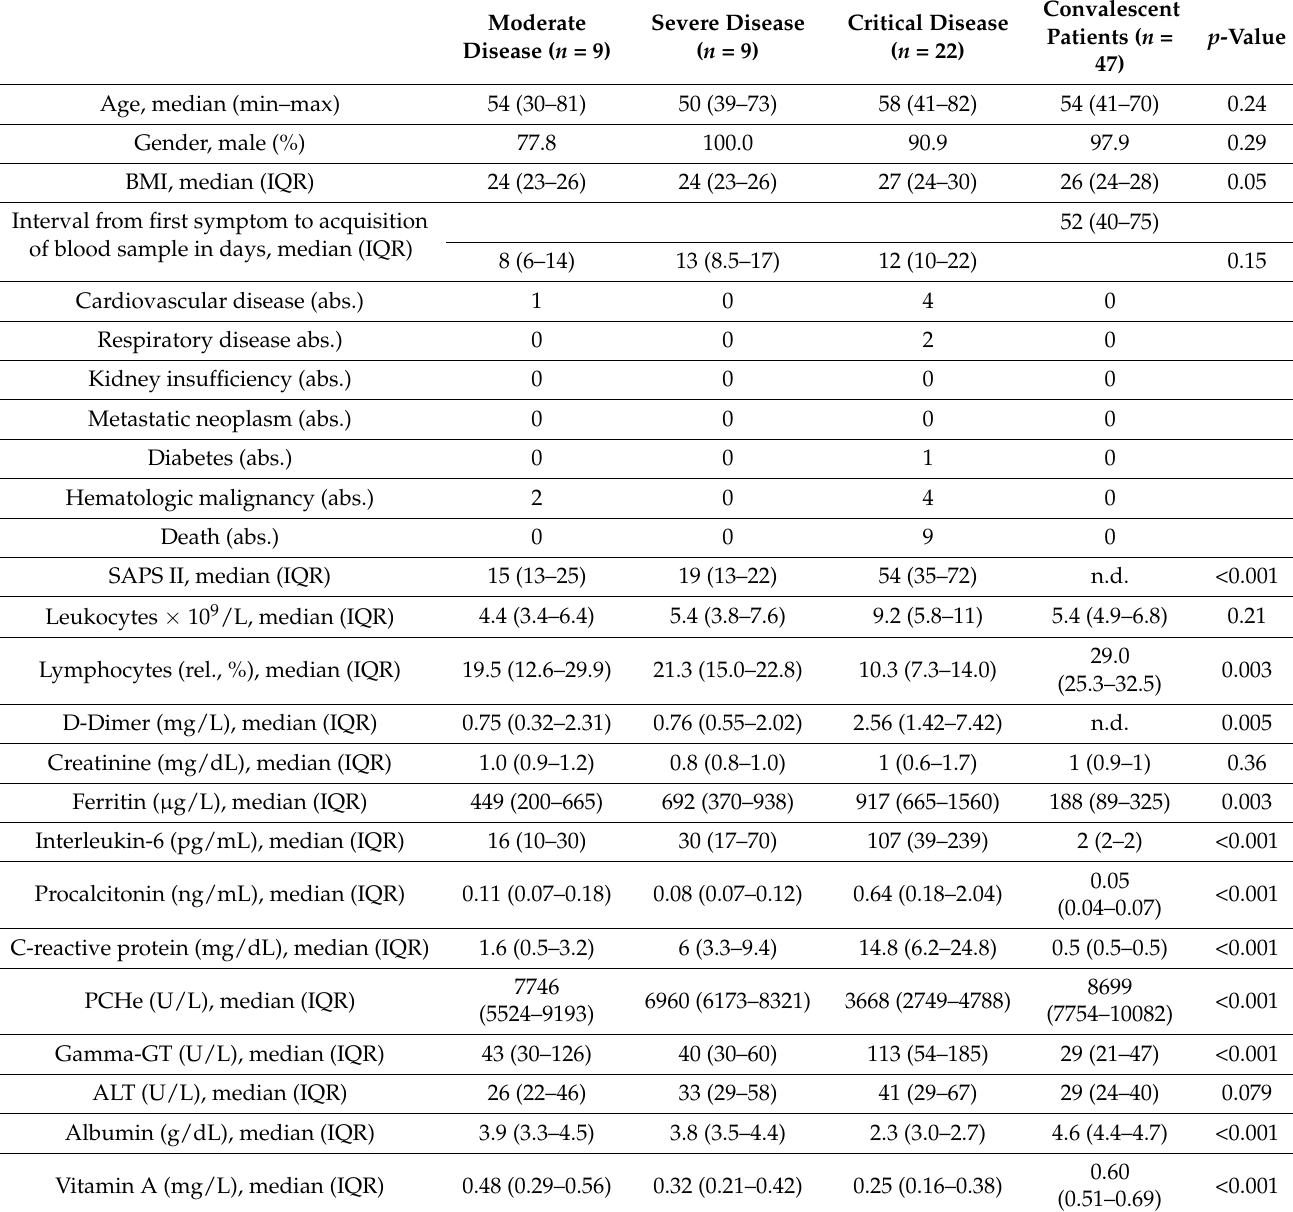
Table 1. Cohort characteristics; differences were calculated via the Kruskal–Wallis test; BMI = body mass index, SAPS II = Simplified Acute Physiology Score II; IQR = interquartile range; LDH = lactate dehydrogenase; PCHe = pseudo- cholinesterase, ALT = alanine aminotransferase; abs. = absolute; n.d. = not